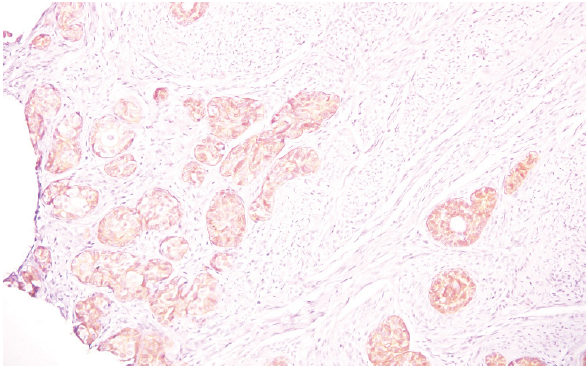
Figure 2: IHC stain (100x) showing diffuse p16 positivity in tumor